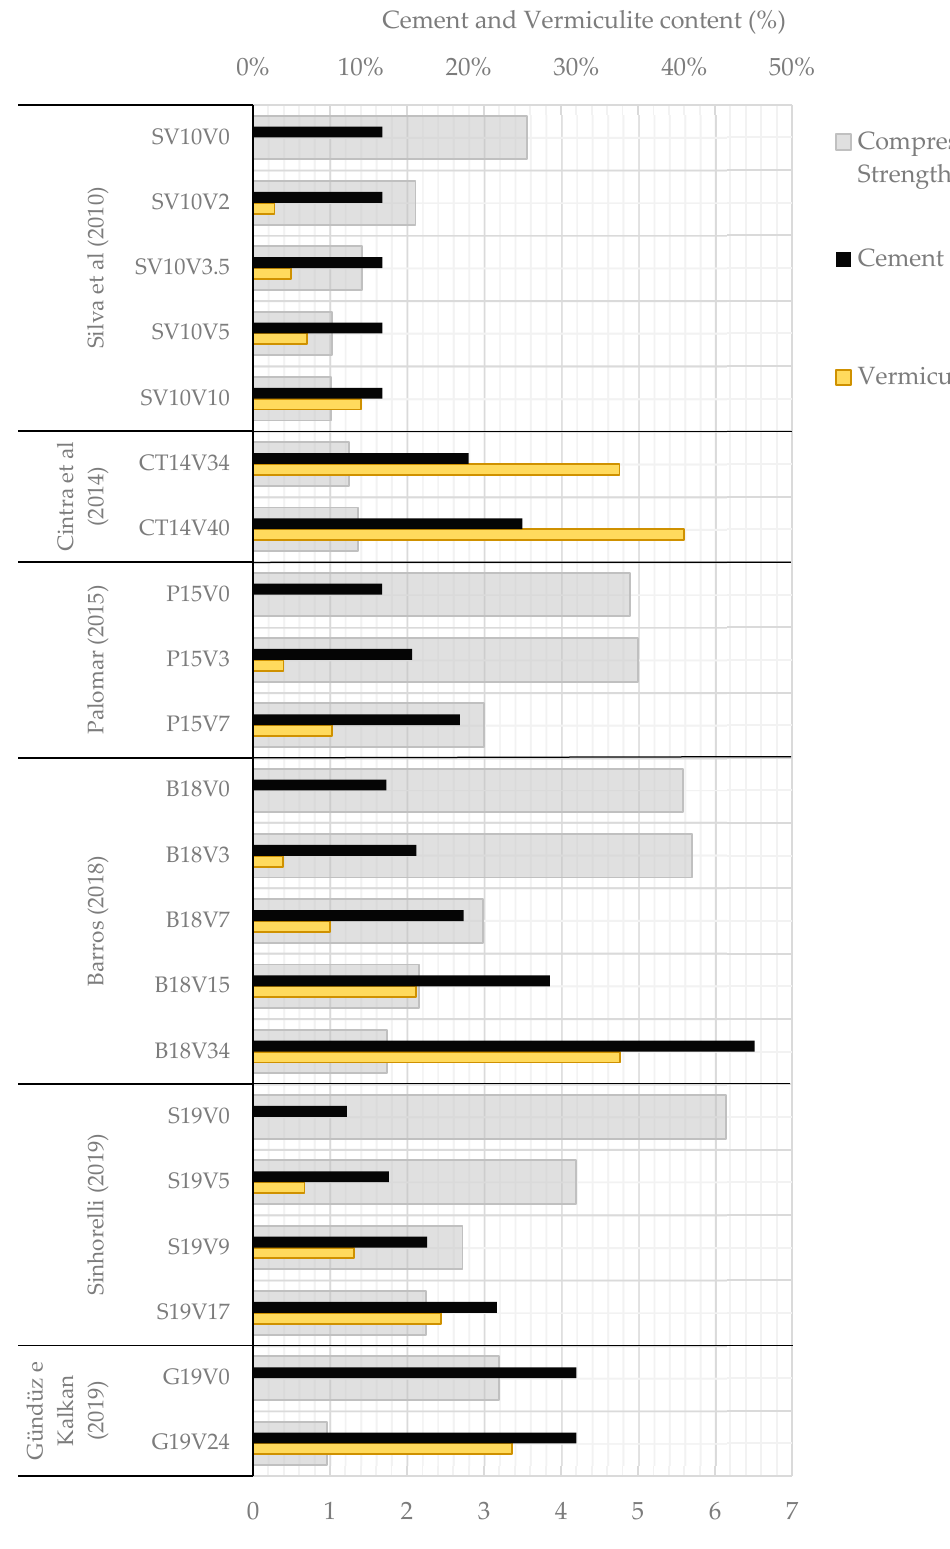
Figure 9. Correlation of the values of compressive strength and cement and vermiculite content of the studied articles [17,41,43–46].